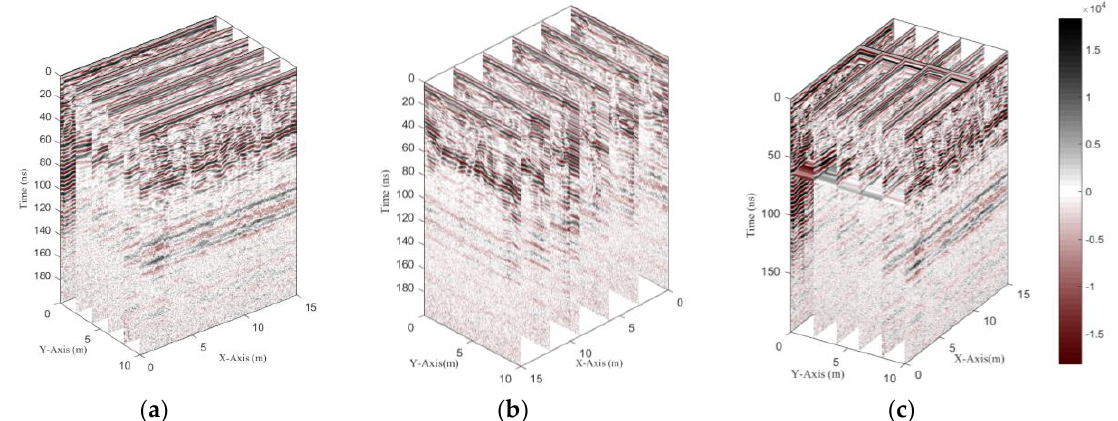
Figure 3. The spatial distribution of 12 lines of data. ( a ) Lines 1,2,3,4,5,6; ( b ) lines 7,8,9,10,11,12; ( c ) Cross and slice display.